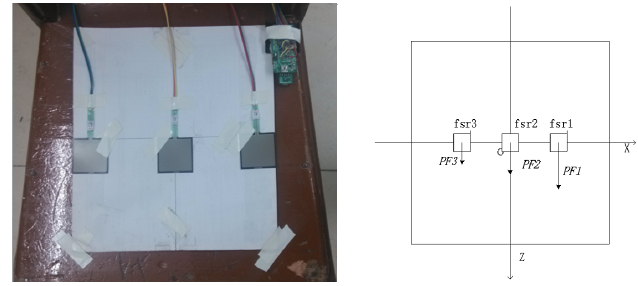
Smart cushion equipped with FSR pressure sensors (left) and representation of pressure sensors data in coordinate system (right).